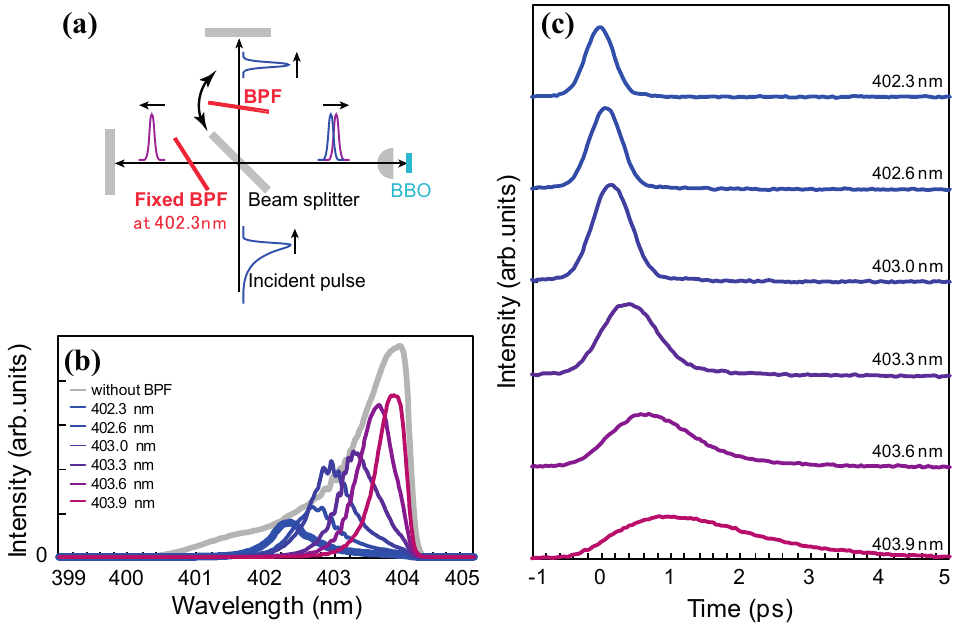
Figure 4. ( a ) Schematic representation of cross-correlation measurement setup to measure the correlation between spectral components at different wavelengths; ( b ) Spectra for cross-correlation measurement. The thick blue trace is the spectrum after the fixed BPF. The additional traces are spectra after the other BPF at different transmission wavelength. The gray trace represents the entire spectrum before the BPF. The wavelength is different from Figure 2b since the MLLD configuration is not the same; ( c ) Cross-correlation signals between the fixed spectral component at 402.3 nm and other spectral components.